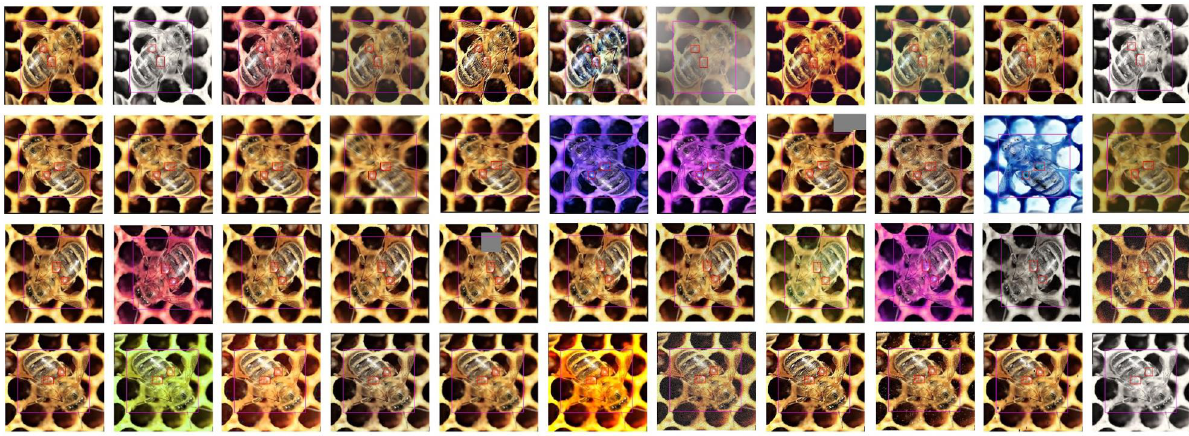
Figure 3. Example of a single image (left top) augmented into the ten more training samples. In the top left column, there is the original image rotated by 0, 90, 180, and 270 degrees. In the rest of the row, there are the images augmented by the ImgAug framework.